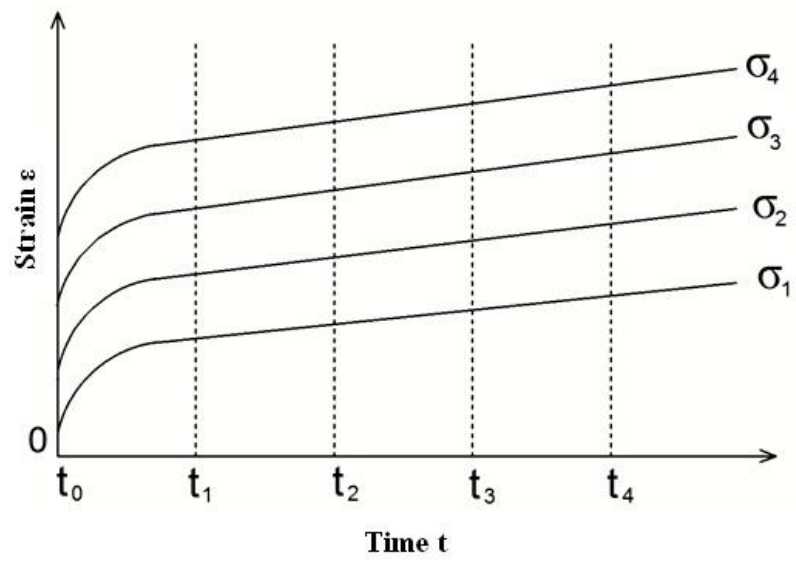
Figure 1. Creep curves of a material at various constant stresses.